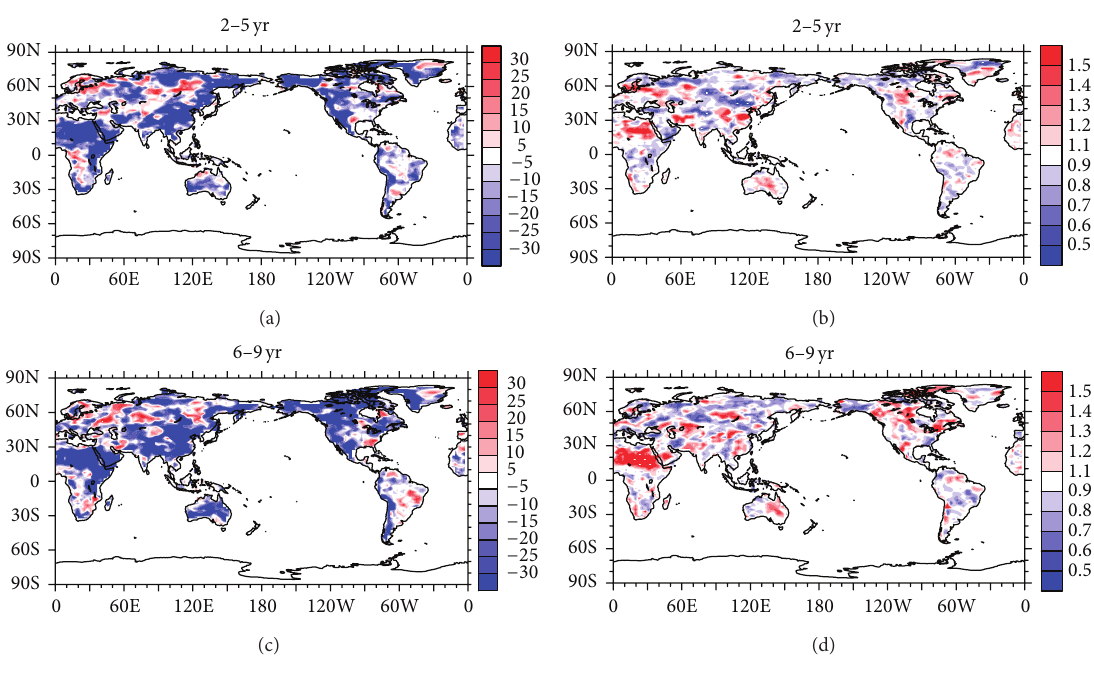
Figure 2: As in Figure 1, but for the land precipitation.